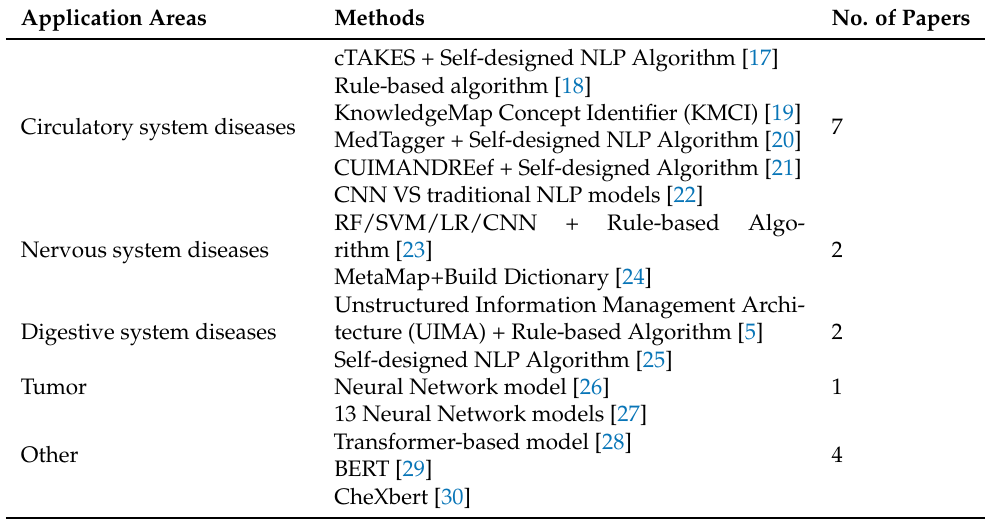
Table 2. Disease areas and implementation methods for medical information retrieval. Application